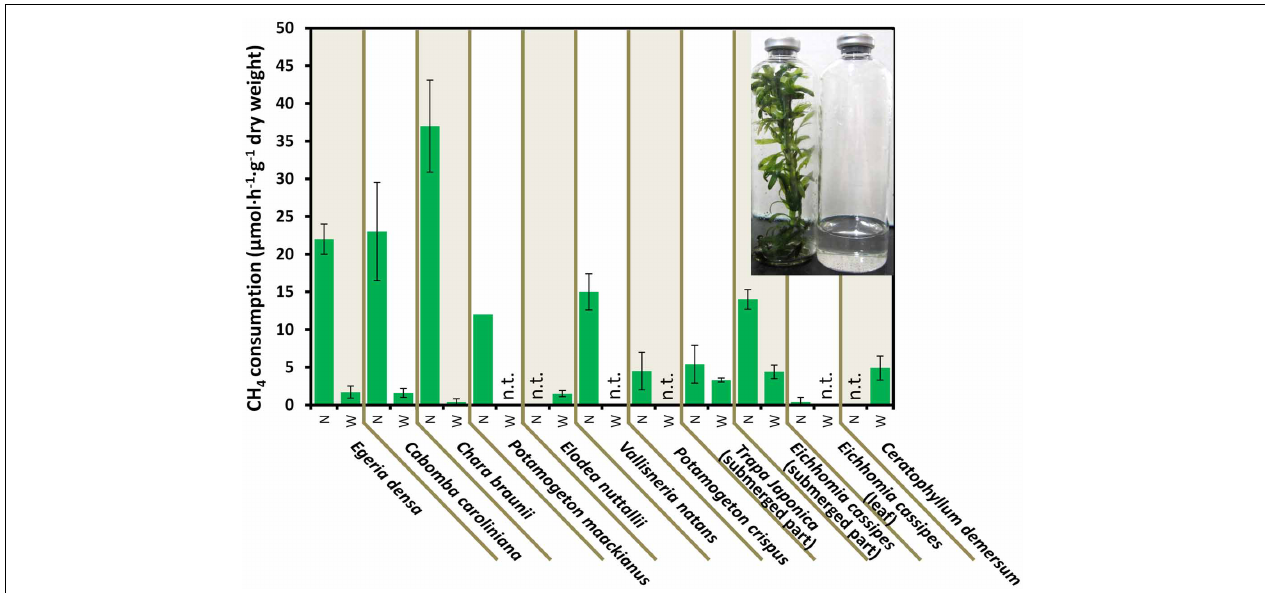
FIGURE 2 | CH 4 consumption in the aquatic plants. Data represent the mean ± SD from three different glass bottles independently prepared in parallel, except for the single determination with P. maackianus . The photo